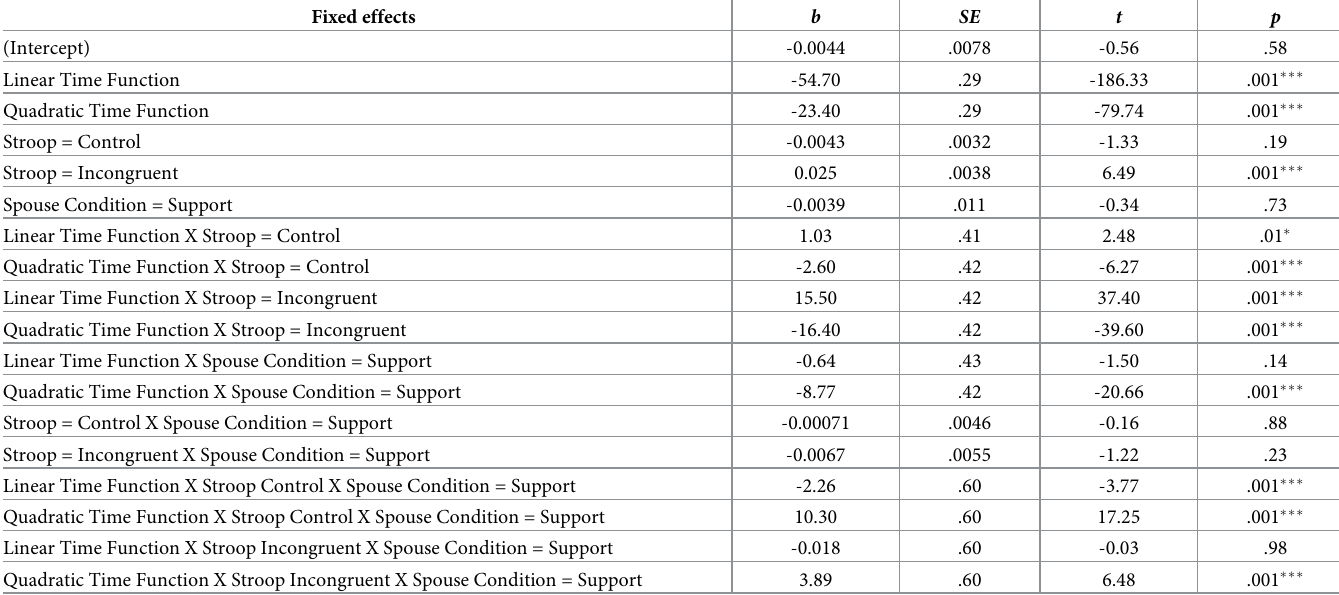
Table 4. Model output of the analysis of phasic pupillary